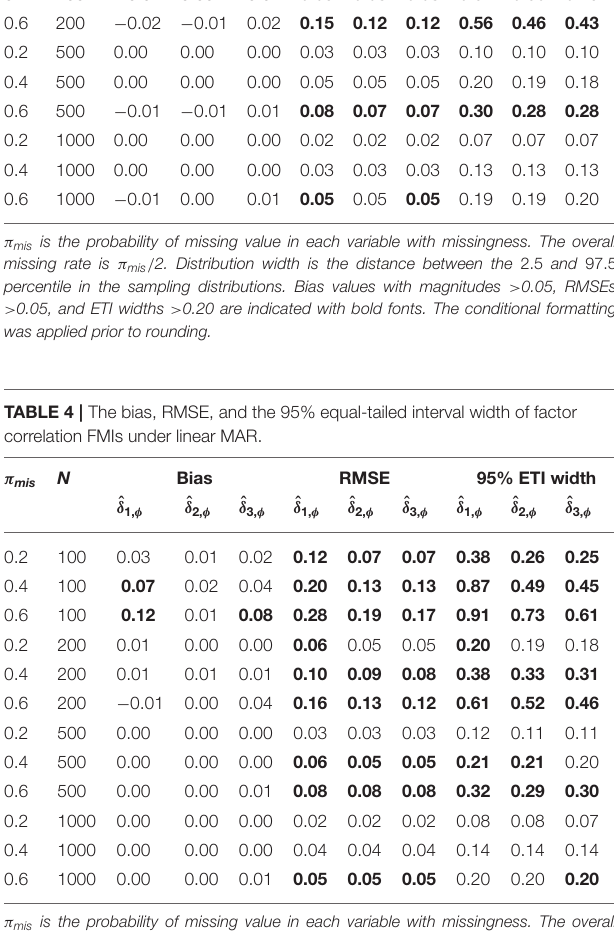
π mis is the probability of missing value in each variable with missingness. The overall missing rate is π mis / 2. Distribution width is the distance between the 2.5 and 97.5 percentile in the sampling distributions. Bias values with magnitudes > 0.05, RMSEs > 0.05, and ETI widths > .20 are indicated with bold fonts. The conditional formatting was applied prior to rounding.